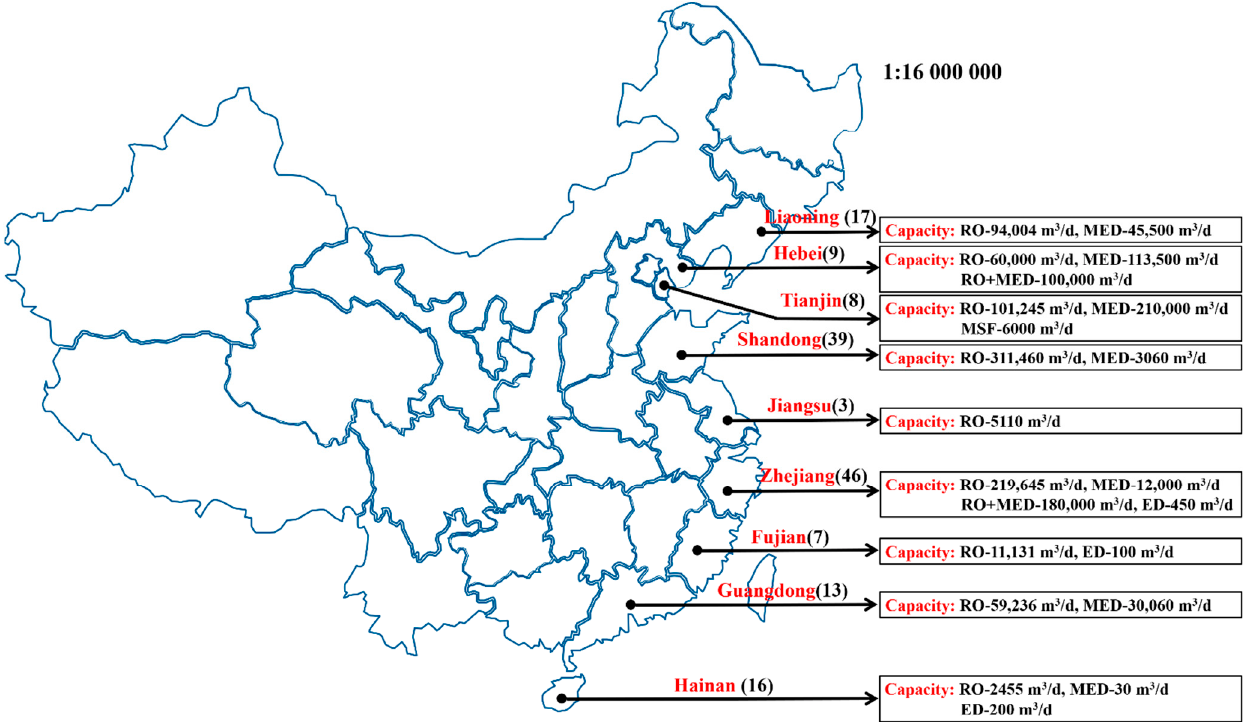
Figure 3. The detailed number and capacity range for local seawater desalination projects in China.